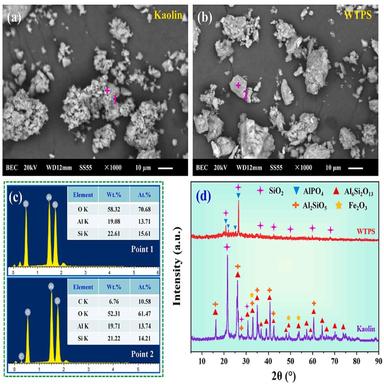
Characterization of dried kaolin and WTPS specimens: (a, b) SEM image, (c) EDS spectrum, (d) XRD pattern.